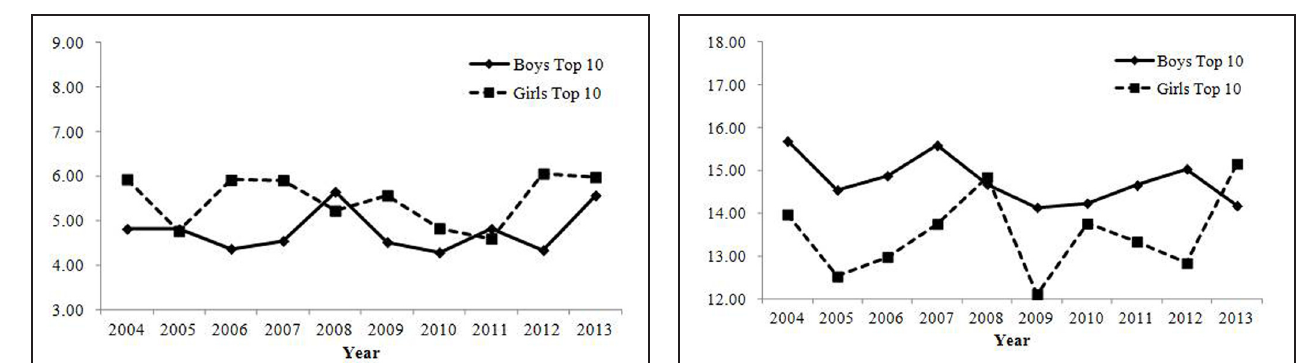
FIGURE 4 | Percentage of babies receiving names with one of the top 10 most common combinations of Chinese characters in Study 2. Changes were small in magnitude, showing that the rate of parents who give common combinations of Chinese characters has not changed over time.